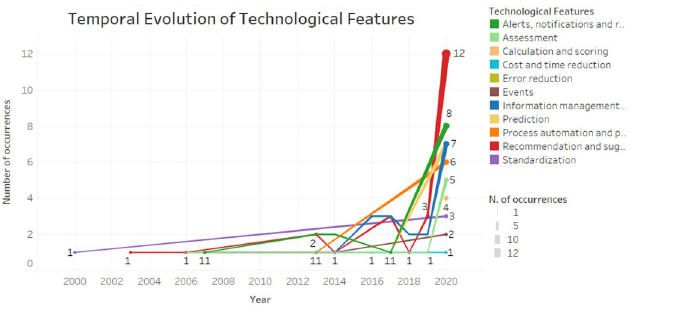
Fig 7. Temporal evolution of CDSS